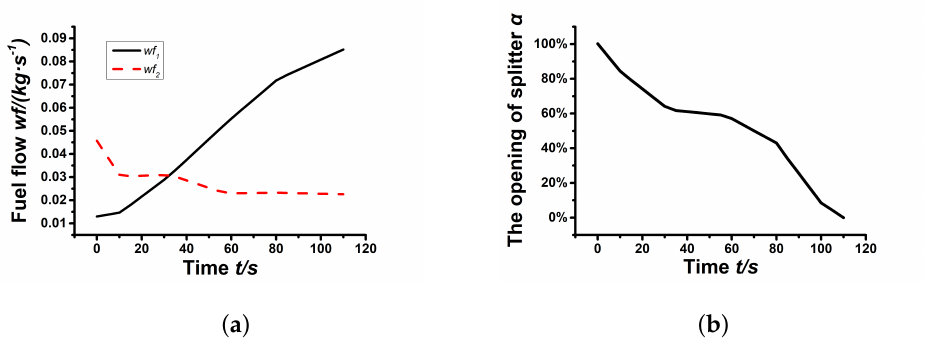
Figure 7. Optimal control laws: ( a ) Fuel’s change of each channel; ( b ) The opening of the splitter. Loading the inputs (42)–(44) into the aerothermodynamic model obtains the real thrust.